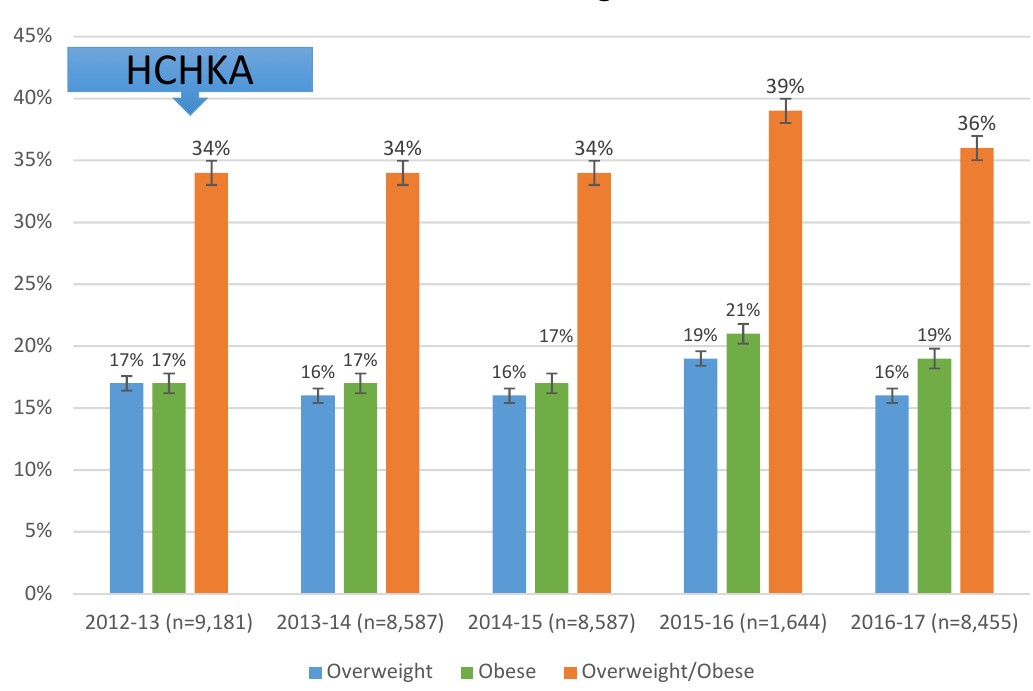
Figure 2. BMI status of Cincinnati Publics School students.